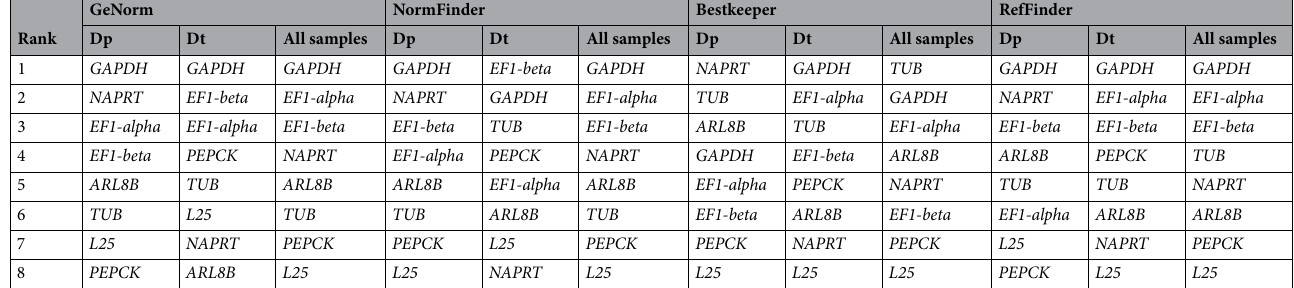
Table 2. Expression stability of the candidate reference genes in samples of P. ternata as calculated by geNorm, NormFinder, BestKeeper and RefFinder. All samples are a combination of samples from different tissues (Dt) and different periods (Dp).